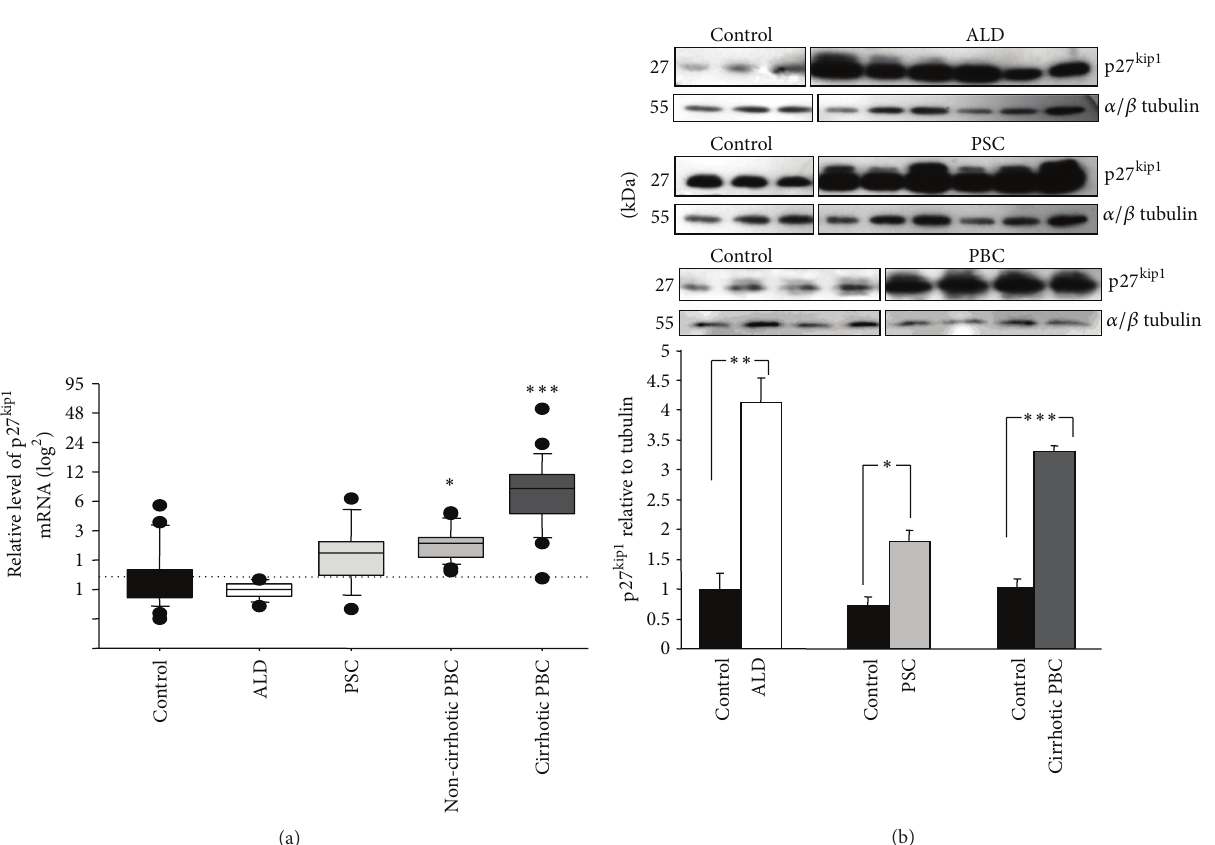
Figure 2: p27 kip1 expression in non-cirrhotic PBC, cirrhiotic PBC, ALD, PSC, and controls. (a) mRNA and (b) protein. Levels of gene expression presented as fold-change relative to control were normalized with GAPDH. Changes in p27 kip1 protein levels were determined by densitometry analyses after normalization to 𝛼 / 𝛽 tubulin as a control for loading. Bars indicate the mean ± SEM ( ∗ 𝑃 < 0.05 ; ∗∗ 𝑃 < 0.005 ; ∗∗∗ 𝑃 < 0.0001 versus